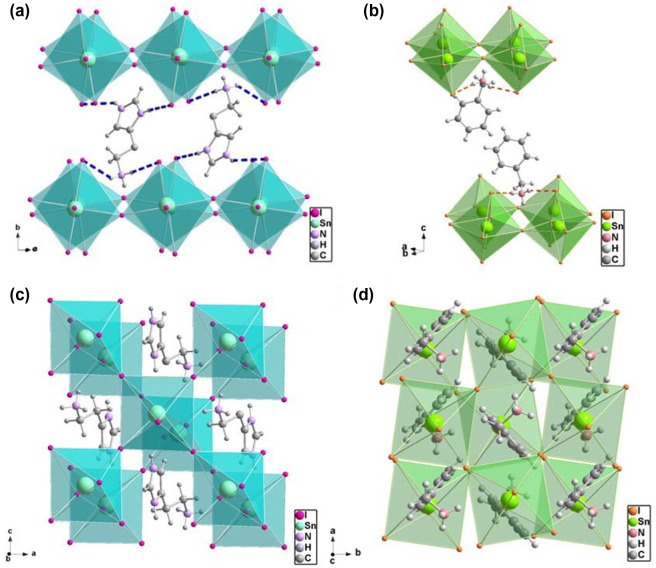
Coordination environment of (a) (HA)SnI4 and (b)(BZA)2SnI4; the Pb analogues of HA2+ and BZA+ have the exact same environments. (c) Top-down view of (HA)SnI4, ‘eclipsed’ conformation; (d) ‘staggered’ conformation of (BZA)2SnI4 [58].